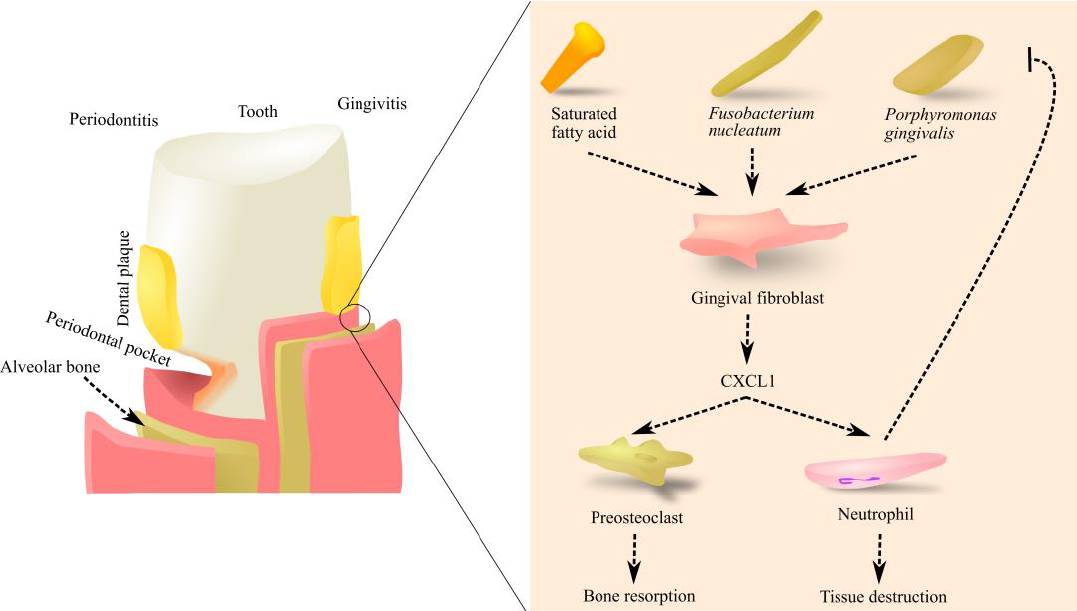
Figure 2. The role of CXCL1 in the formation of periodontitis. When teeth are not sufficiently cleaned, dental plaque is formed. It contains the bacteria Fusobacterium nucleatum and Porphyromonas gingivalis , which cause an increase in CXCL1 production by gingival fibroblasts. This effect is increased by a fatty diet and saturated fatty axis. CXCL1 causes the recruitment of neutrophils, which destroy microorganisms. On the other hand, neutrophils also contribute to tissue destruction. CXCL1 also acts on preosteoclasts, causing their migration and osteoclastogenesis. This leads to alveolar bone resorption. As a consequence of these processes, periodontal pockets and periodontitis are formed. Abbreviations: CXCL1 — CXC motif chemokine ligand 1. Source: own elaboration.